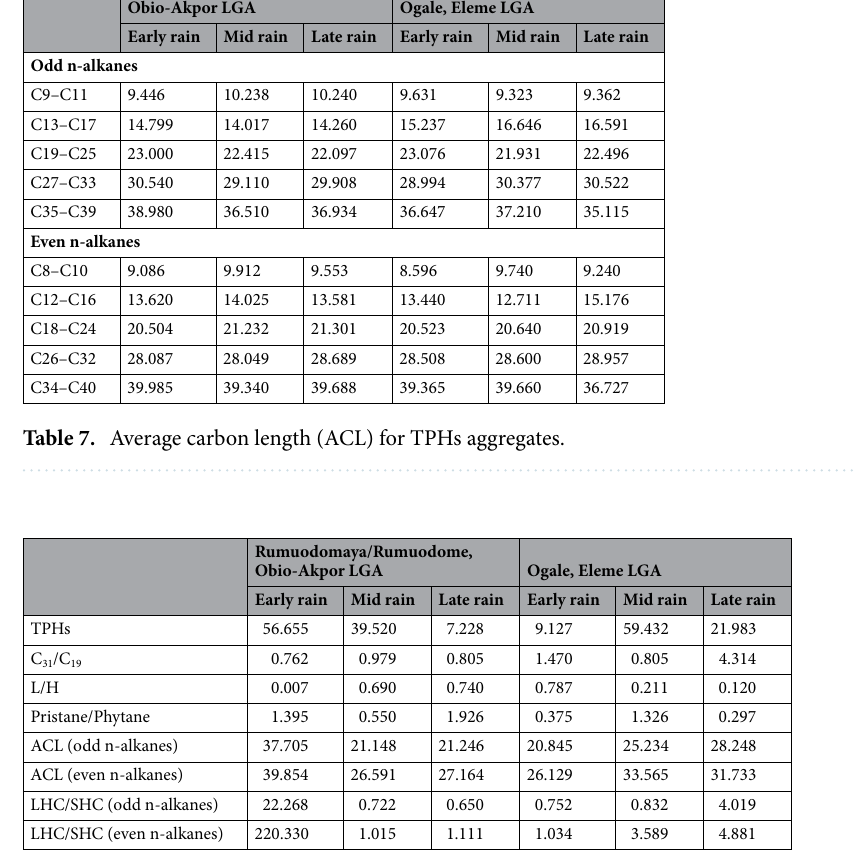
Table 8. Petroleum hydrocarbons source diagnostic